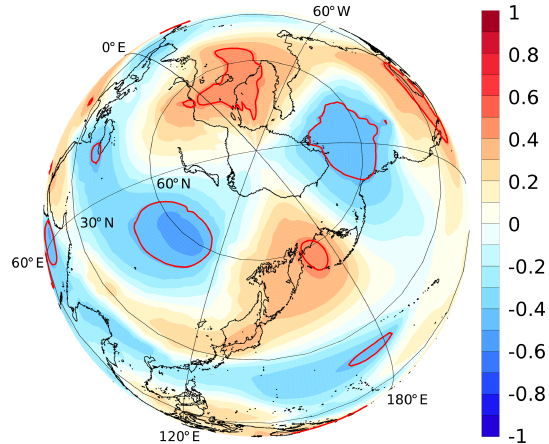
Figure 3. PMIP2 and PMIP3 linear correlations between JJA 500hPa stationary wave geopotential height anomalies at any given location and JJA temperature anomalies averaged over the Siberian target region (see Fig. 1 for the definition). Anomalies are calcu- lated with respect to PI, and zonal mean geopotential height fields are subtracted before calculating the anomalies. The red contours bound the areas for which the correlation is significant ( p < 0 . 1). The LGM coastlines are given in